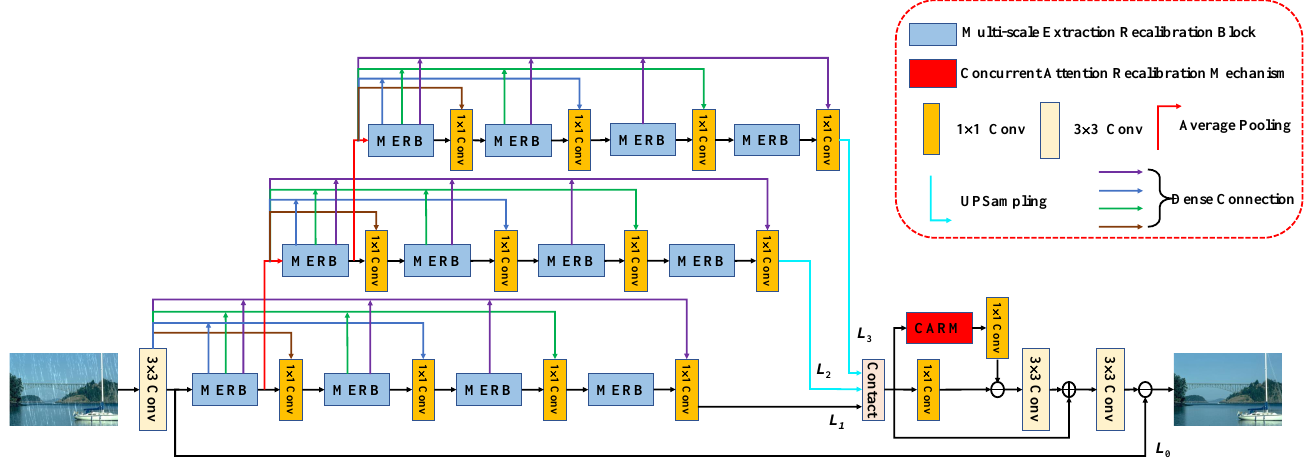
Figure 1. The proposed Scale-space Feature Recalibration Network